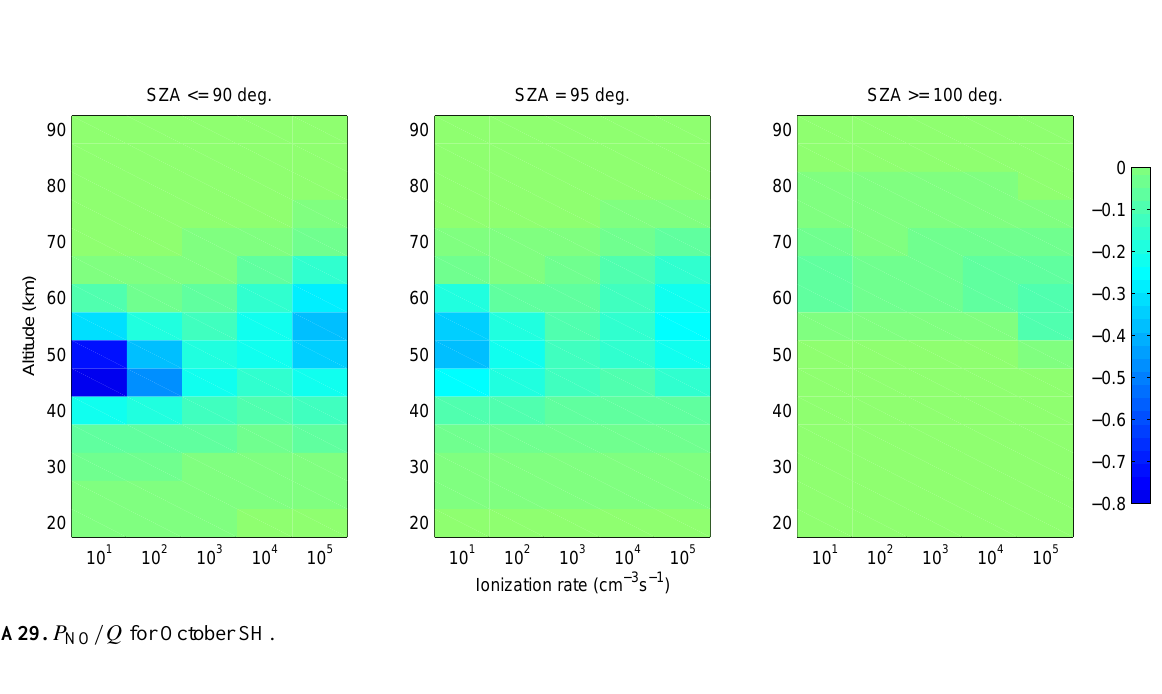
Fig. A29. P NO /Q for October